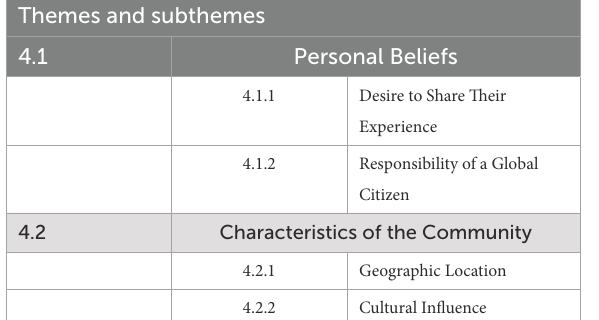
TABLE 2 Themes and